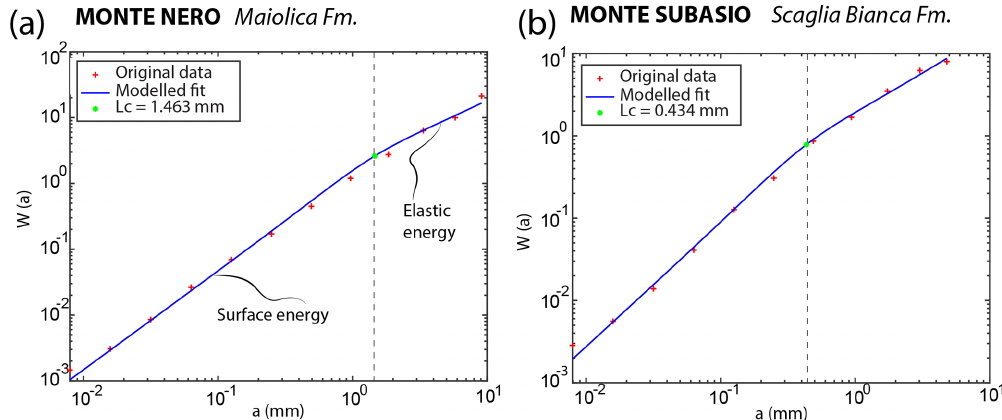
Figure 5. Examples of results of stylolite roughness inversion, with signal analysis by Average Wavelet in Monte Nero (a) and in Monte Subasio (b)